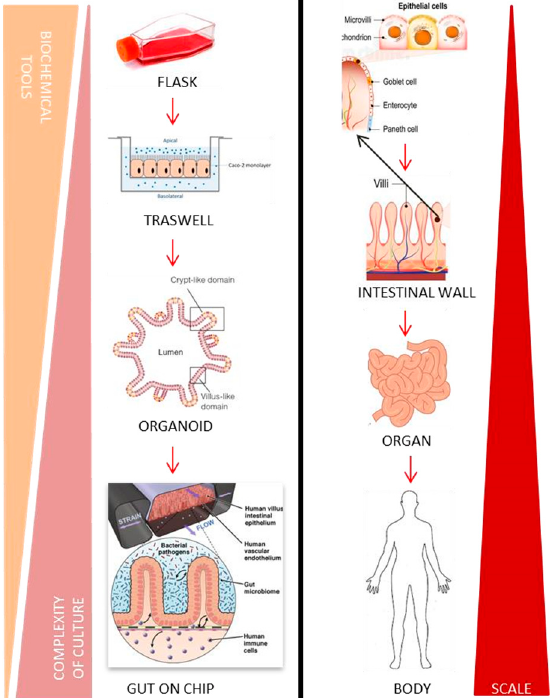
Figure 1. On the left many models are presented of witch that have been developed across this organismal hierarchy, to address specific challenges in medicine. On the right there is a life system hierarchy: from the subcellular level to the whole body. Inspired from Cell Press Copyright© 2016 Elsevier Inc. Published by Elsevier Inc. (Amsterdam, The Netherlands)